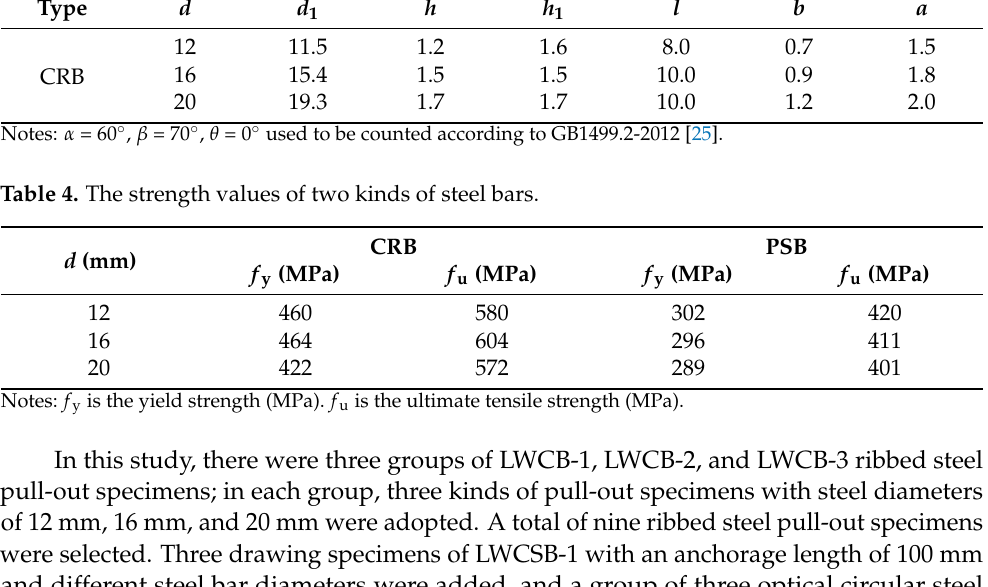
Table 4. The strength values of two kinds of steel bars.